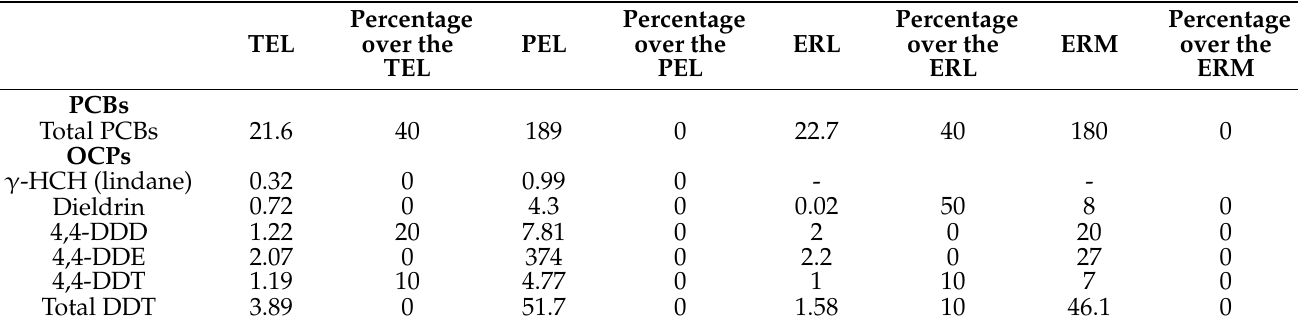
Table 3. A comparison of the TEL, PEL, ERL and ERM guideline values ( µ g Kg − 1 ) for PCBs and OCPs and data from the Sele river and estuary, southern